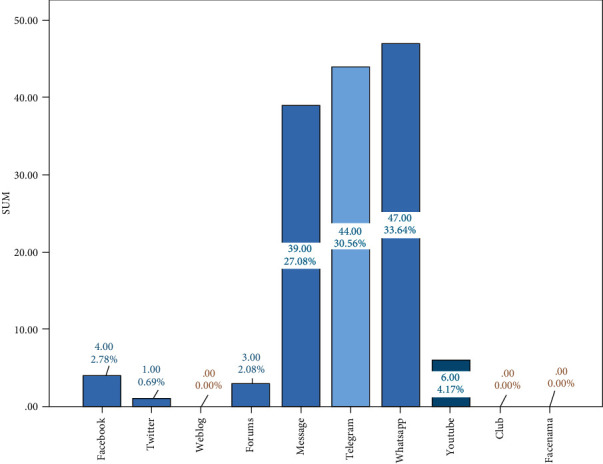
The percentage of MS patient using each social networks.